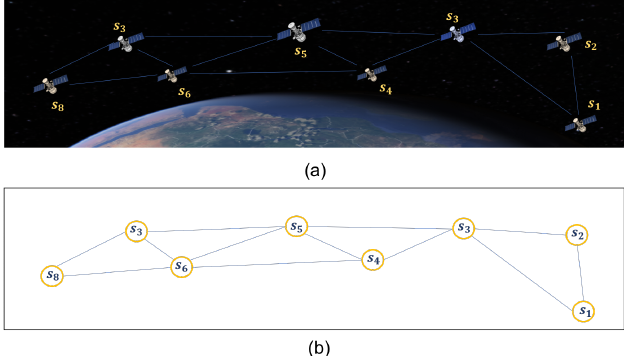
Figure 2. Communication graph illustration. ( a ), The satellites constellation and ( b ) the FSO commu- nication graph created by such a